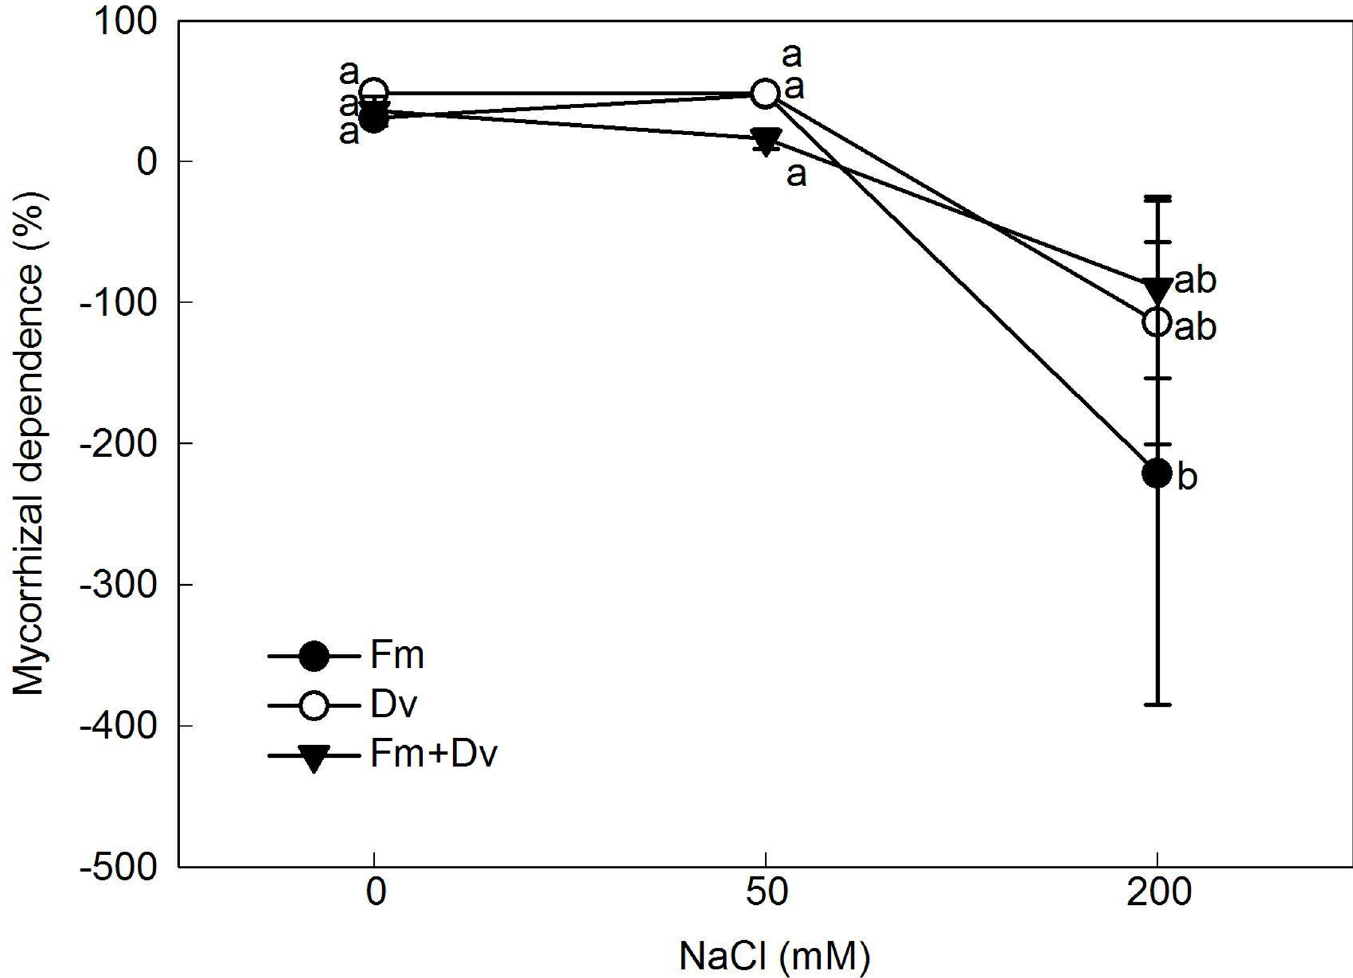
Fig 3. The mycorrhizal dependence of C . morifolium plants under 0, 50 and 200 mM NaCl. Symbols are the same as in Fig 1.